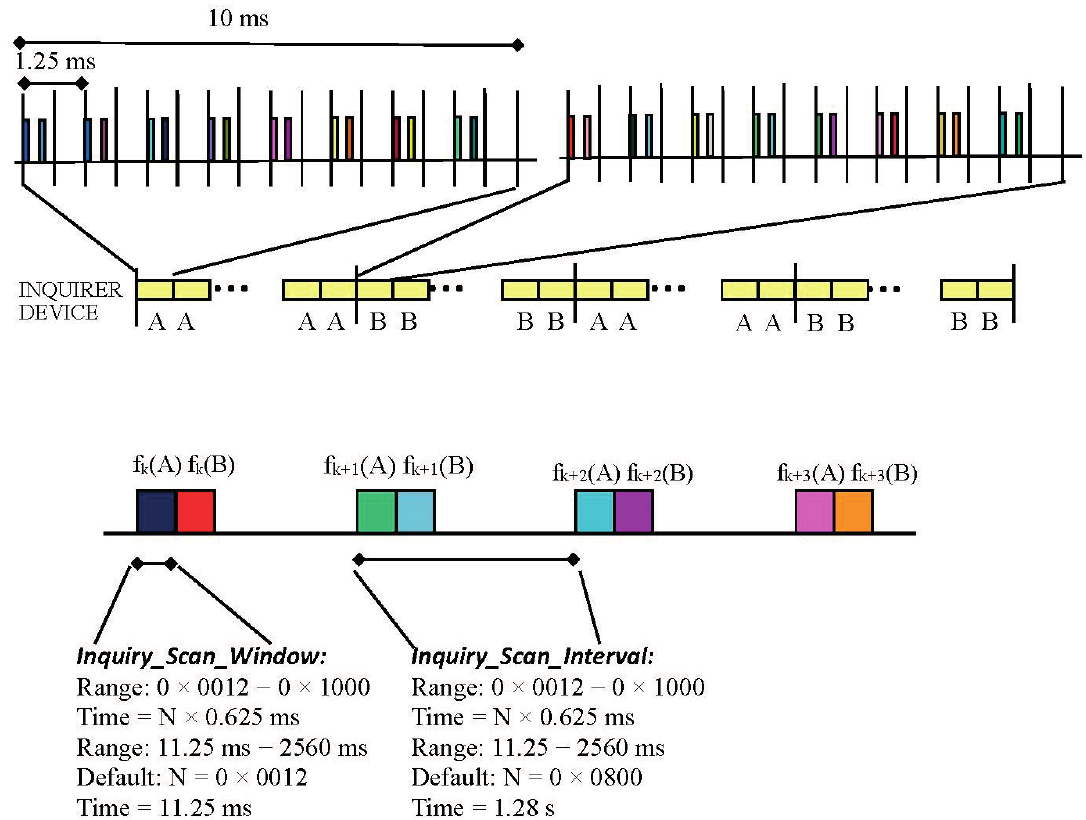
Figure 4. Inquiry process